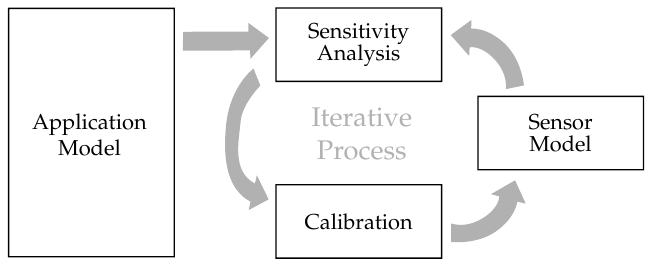
Figure 4. The idea of application-centric calibration